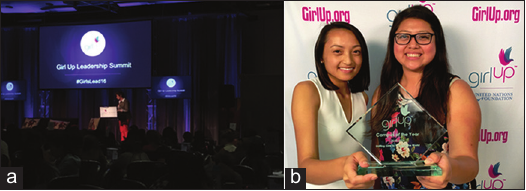
Figure 2: Photos from Girl Up Leadership Summit and Girl Up (https://girlup.org/). (a) UN Deputy High Commissioner for